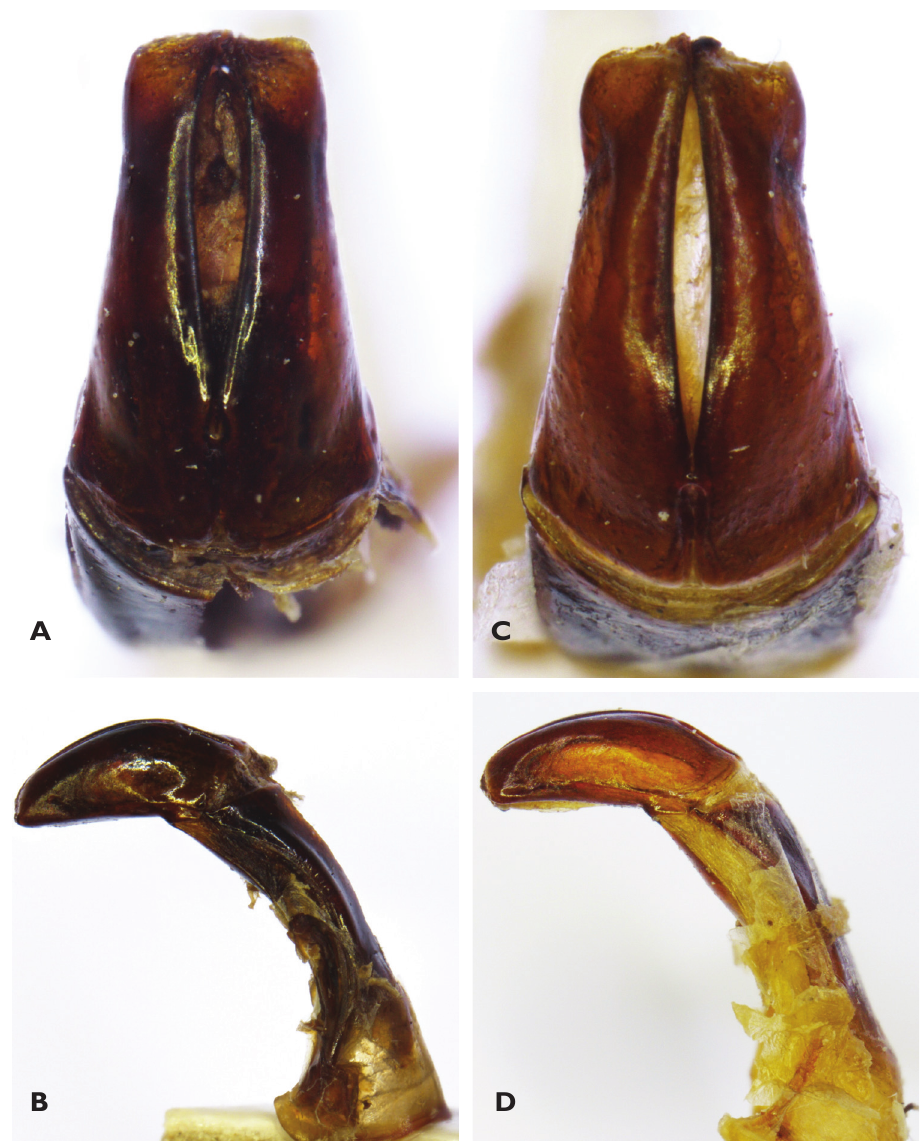
Figure 3. Dorsal ( A ) and lateral ( B ) views of aedeagal parameres of Lamellothyrea descarpentriesi (Mar- racuene, Mozambique); dorsal ( C ) and lateral ( D ) views of same for Lamellothyrea isimangaliso sp. n. (St Lucia, South